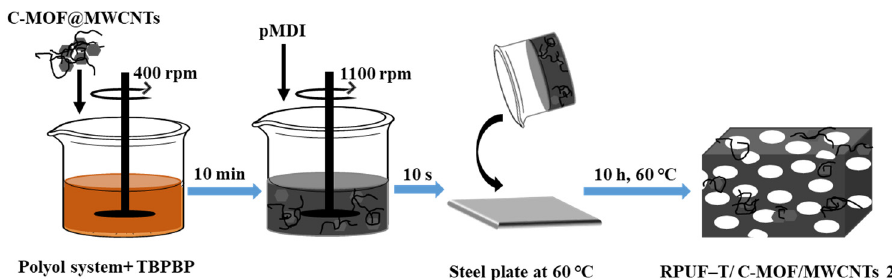
4 of 23 Table 1. The formulation of bio-based RPUFs.